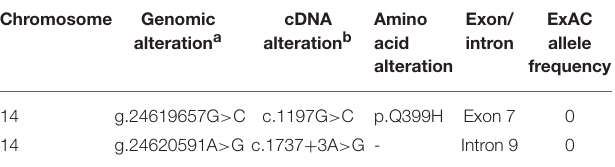
FIGURE 1 | Clinical characteristics of the HOIP deficient patient. (A) Eczematous dermatitis. (B) Histopathology of the skin biopsy sample. (C) Information about the pedigree and the detected variants. (D) Genomic architecture of the RNF31 gene through exons 6 to 10. ZF: zinc finger; NZF: Npl4-zinc finger; UBA: ubiquitin-associated. (E) Subcloning of the RT-PCR product demonstrated multiple forms of aberrant splicing. The table demonstrates the number of clones. TABLE 1 | RNF31 mutations identified in the